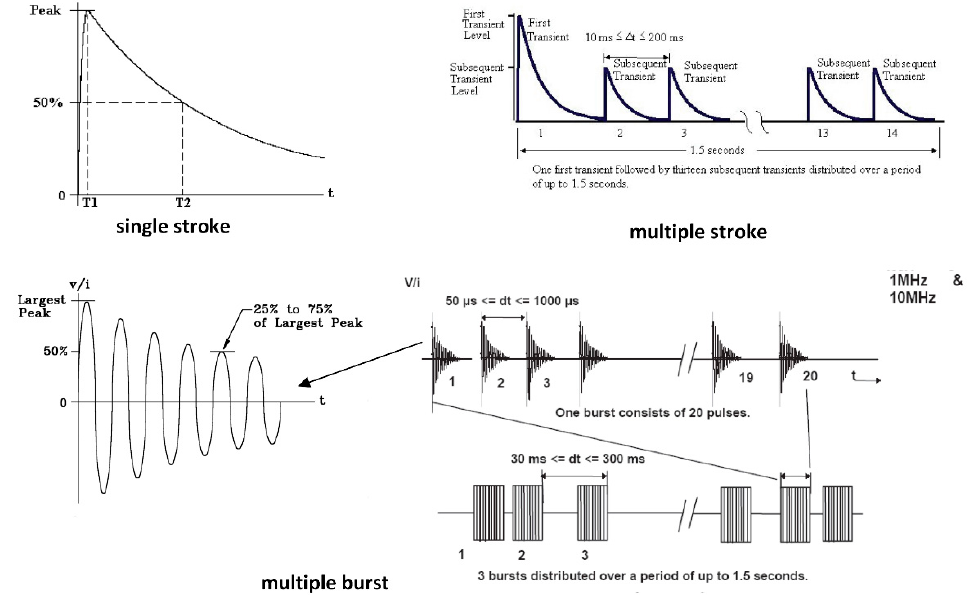
Figure 4. Standardized waveforms recommended for indirect lightning tests of avionics immunity according to DO-160 standard [16].